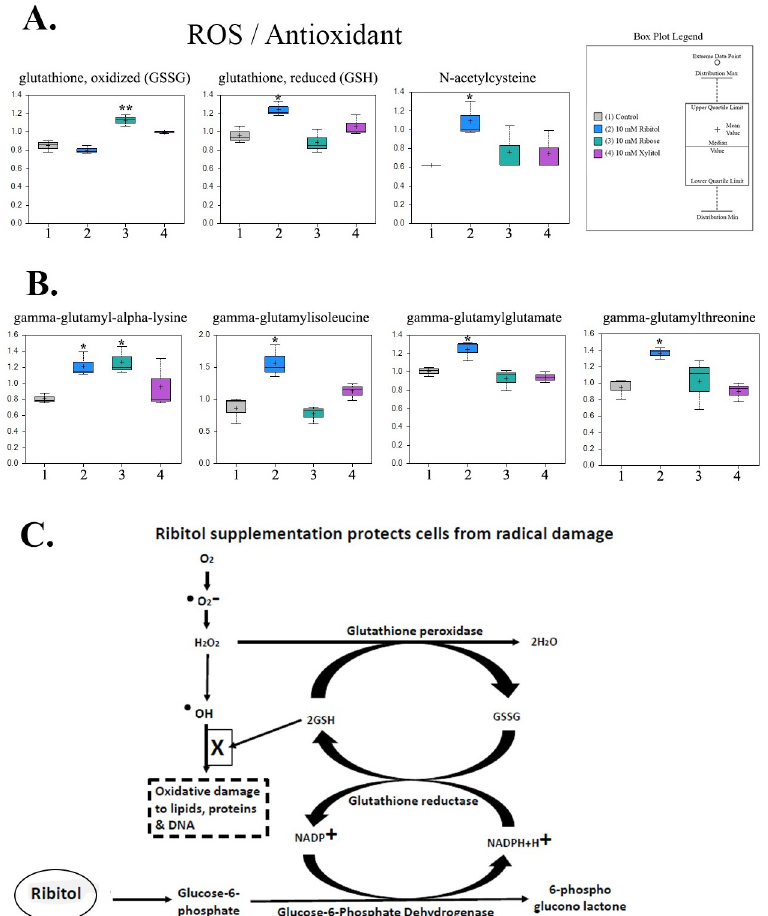
Fig 5. Alteration of glutathione metabolism in MCF-7 breast cancer cell line, treated with ribitol, ribose, and xylitol. (A) Ribitol treatment of MCF7 cells leads to increased levels of reduced glutathione (GSH) and decreasing the oxidized glutathione (GSSG), this is completely contrast to ribose treatment. (B) Box plot levels of gamma- glutamyllysine and gamma-glutamylisoleucine and gamma-glutamylglutamate, gamma-glutamylthreonine under ribitol, ribose, and xylitol treatments. (C) Hypothetical model of ribitol treatment increases glucose-6-phosphate which convert to 6-phosphogluconolactone by generating NADPH+H + . In the presence of glutathione reductase and NADPH+H + , oxidized glutathione is converted to reduced glutathione which prevents oxidative damage to lipids, proteins, and DNA. Significance denoted by � p � 0 . 05 , �� p � 0 . 01 , ��� p � 0 . 001 within individual metabolite box plots, as determined by Welch’s two-sample